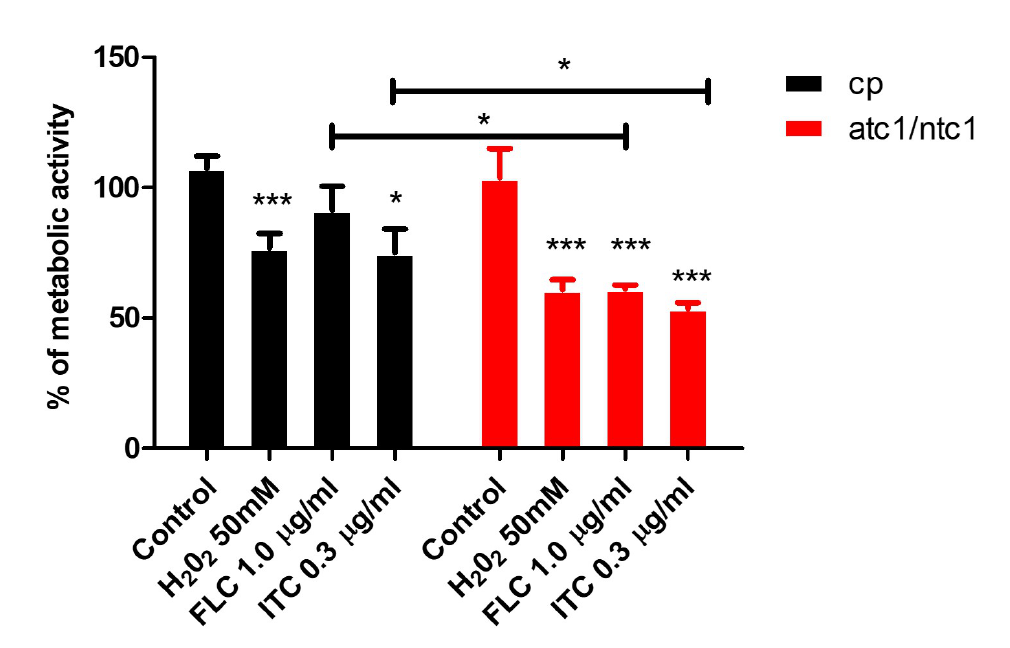
Figure 4. Biofilm formation by the parental strain of C. parapsilosis and the trehalase-deficient null mutant atc1 ∆ /ntc1 ∆ . Biofilms were preformed for 24 h in 96-well plates. At this moment, FLC, ITC, and H 2 O 2 were added at the indicated concentrations. Metabolic activity was quantified after 24 h by XTT reduction assay. Results are expressed as mean ± standard deviation of two experiments with five replicates for each group. Statistically significant differences (* = p < 0.05; *** = p < 0.001) were recorded with respect to an untreated control according to the Mann–Whitney U